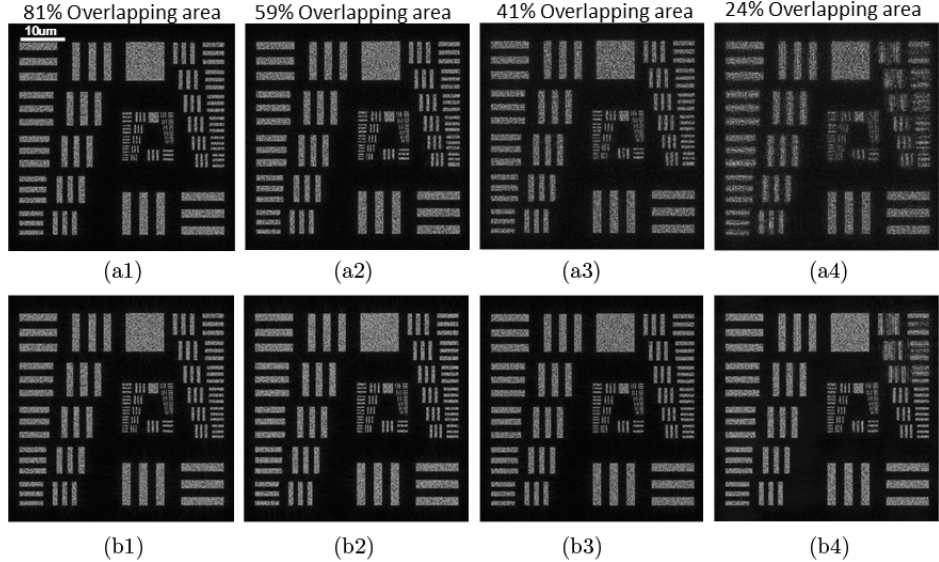
Fig. 9. FPM's recovery of resolution target with random phase. (a1) – (a4) Intensity images reconstructed by iterating for once with 81%, 59%, 41%, and 24% overlapping area, respectively. (b1) – (b4) Intensity images reconstructed by iterating until converges with the corresponding overlapping